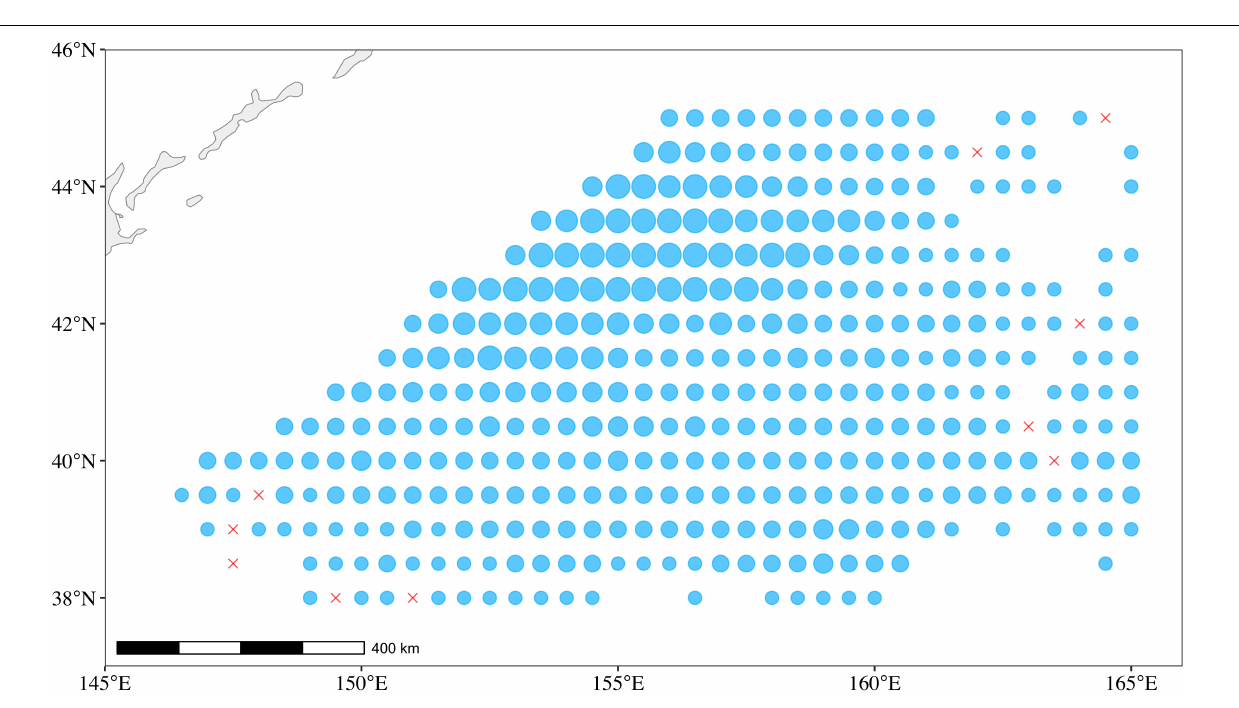
FIGURE 2 | The catch and fishing ground for O. bartramii in the Northwest Pacific Ocean. The size of the circle is proportional to the catch of O. bartramii during 2005–2018. The red crosses represent zero